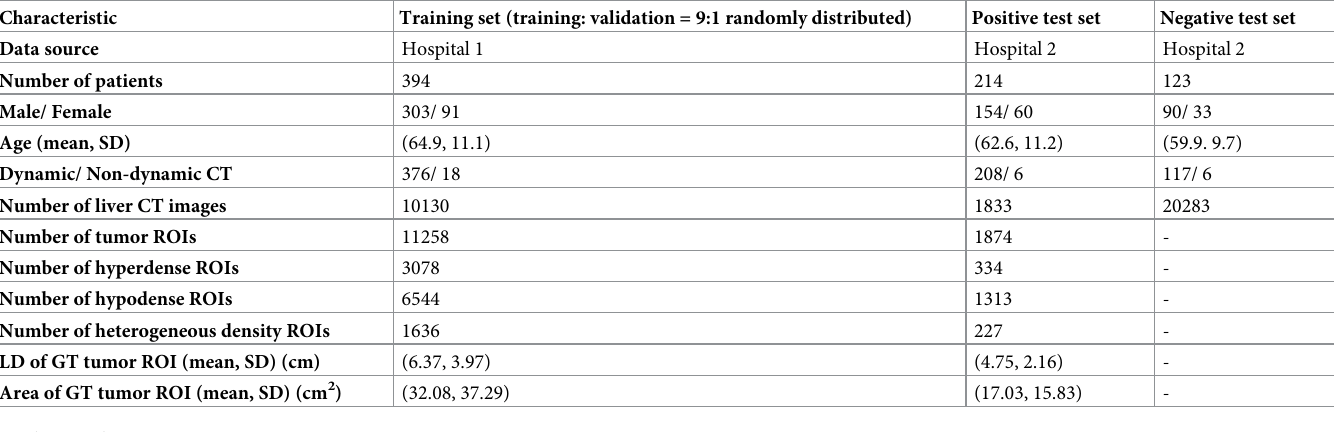
Table 1. Properties of training and testing